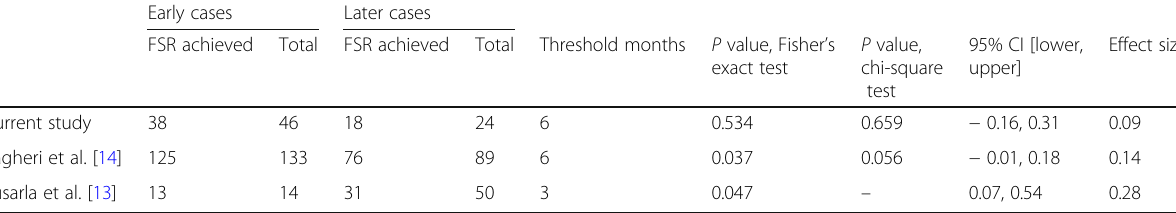
Table 6 Relationship between FSR achievement and the duration from injury to the microneurosurgery in our study and in past